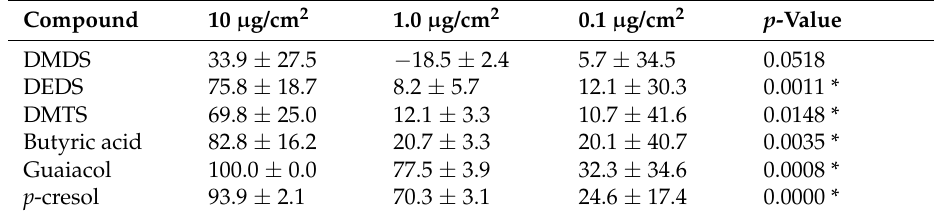
Table 4. Effect of PureTi coat loading densities on odor compounds. Reduction rate (%) at a treatment time of 200